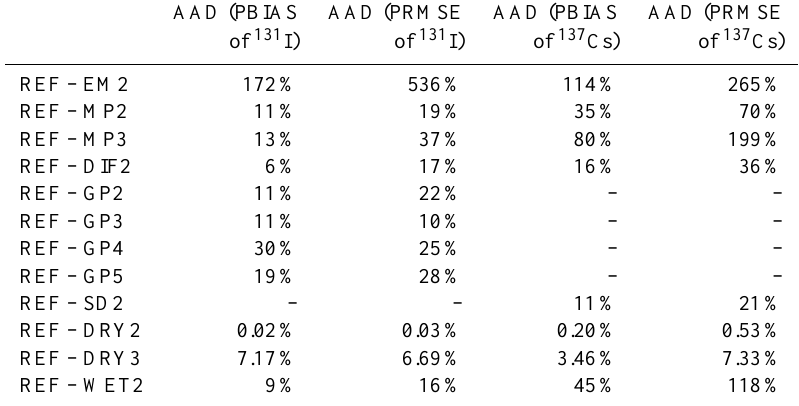
Table 11. The averaged absolute value of the difference (AAD) between the error in the reference case and that in different sensitivity